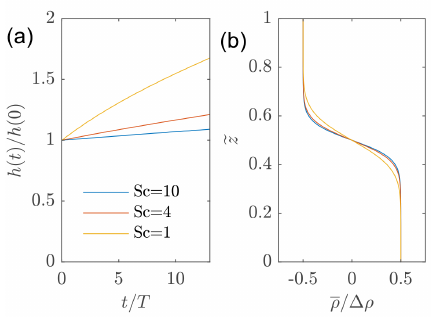
Figure 13. (a) Pycnocline half-width as a function of time for different Schmidt numbers. (b) The background stratification at e t = 12 . 5 (t = 120s )